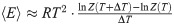

(A) Average run times, with (tiny) error-bars of ±1 standard deviation, for each of the five methods DP, FTD (ΔT = 10−7), SCFG(G6,Benchmark), SCFG(G4,Benchmark), and SCFG(G5,Benchmark). Averages were determined for 100 random RNA sequences of length n, each having expected compositional frequency of 0.25 for A,C,G,U, where n ranges from 20 to 500 with increments of 5. Methods tested are as follows: (1) DP: dynamic programming computation of expected energy 〈E〉 and partition function to yield H = 〈E〉/RT + ln Z, with Turner 2004 energy parameters. (2) FTD: formal temperature derivative method which computes 〈E〉≈RT2·lnZ(T+ΔT)-lnZ(T)ΔT, where the temperature increment T+ΔT is applied only to occurrences of T within the expression RT—i.e. formal temperature, as explained in the text. Increment ΔT is 10−7, and Turner 2004 energy parameters are used. (3) SCFG: computation of derivational entropy using the method of [24], for the grammars G4, G5, G6 with grammar rule probabilities from ‘Benchmark’ data (see [24, 28]). SCFG executables and models downloaded from http://rna-informatics.uga.edu/malmberg/. The methods, ordered from fastest to slowest, are as follows: FTD, DP, G5, G6, G4, where FTD and DP are approximately equally fast, while the slowest methods, G6 and G4, have almost identical run times. DP and FTD are an order of magnitude faster than G6. (B) Average entropy values, with error bars of ±1 standard deviation, computed by the methods DP, FTD (ΔT = 10−7), SCFG(G4,Benchmark), SCFG(G5,Benchmark), and SCFG(G6,Benchmark) for the same data set as in the left panel. The methods, ordered from those returning smallest entropy values to largest, are as follows: FTD, DP, G6, G4, G5. FTD and DP return essentially identical values, with a small deviation for larger sequences due to the finite approximation of the formal temperature derivative.